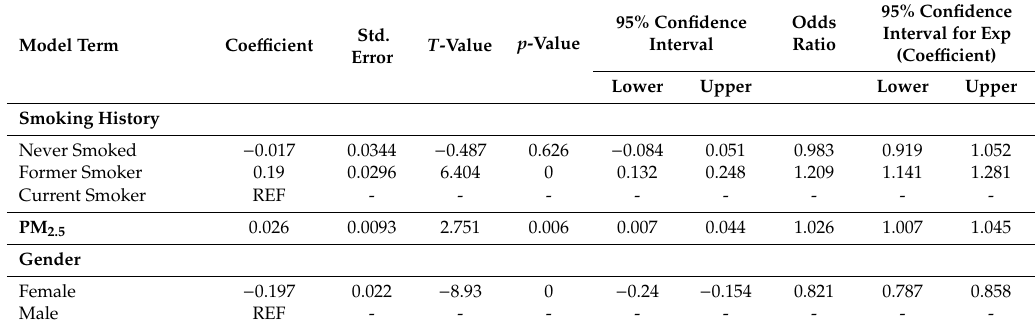
Figure 3. Individuals by race and gender with hypertension and BMI between 30 and 35 vs. individuals by race and gender without hypertension and BMI below 30.